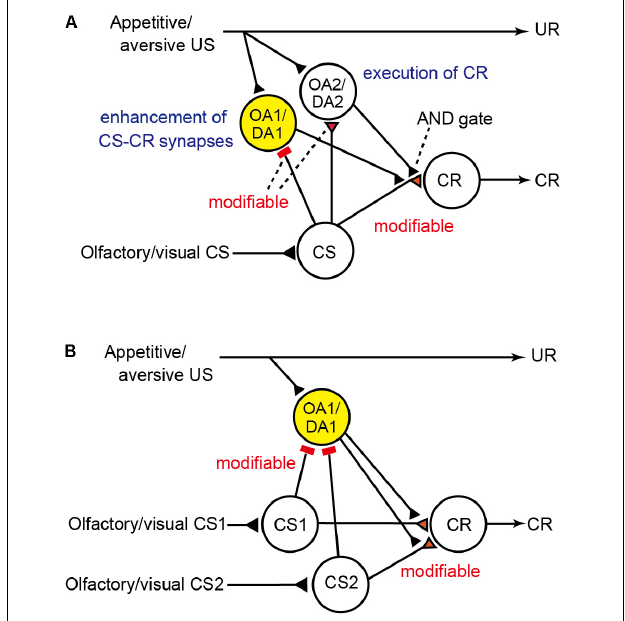
FIGURE 1 | Neural models of Pavlovian conditioning in crickets proposed by Terao et al. (2015) and Terao and Mizunami (2017). (A) Description of the model that has been revised from the model by Mizunami et al. (2009) to match the prediction error theory. The model assumes two classes of OA and DA neurons. One is “OA1/DA1” neurons (colored in yellow) that govern enhancement of “CS-CR” synapses (but not execution of a CR). The other is “OA2/DA2” neurons that govern execution of a CR or memory retrieval (but not enhancement of “CS-CR” synapses). The model also assumes that (1) “CS” neurons [which may represent intrinsic neurons (Kenyon cells) of the mushroom body] that convey signals for CS make silent or weak synaptic connections with dendrites of “CR” neurons [which may represent efferent (output) neurons of the lobes (output regions) of the mushroom body], activation of which leads to a CR, but these synaptic connections are silent or very weak before conditioning, (2) “OA1/DA1” neurons receive excitatory synapses that represent appetitive/aversive US signals and silent or very weak inhibitory synapses from “CS” neurons before training, which are strengthened by CS-US pairing, (3) during training, “OA1/DA1” neurons receive excitatory synaptic input that represents actual US and inhibitory input from “CS” neurons that represents US prediction by CS, and thus their activities represent US prediction error signals, (4) “OA2/DA2” neurons receive excitatory synapses that represent US signals and silent or very weak excitatory synapses from “CS” neurons before training, which are strengthened by CS-US pairing, and (5) “OA2/DA2” neurons make synaptic connections with axon terminals of “CS” neurons, and coincident activation of “CS” neurons and “OA2/DA2” neurons is needed for activation of “CR” neurons (AND gate) and for production of a conditioned response. Presentation of a CS after CS-US pairing activates “CS” neurons and then “OA2/DA2” neurons and thus activates “CR” neurons to lead to a CR. Synapses for which the efficacy can be changed by conditioning are colored in red and marked as “modifiable.” Excitatory synapses are marked as triangles, and inhibitory synapses are marked as bars. UR: unconditioned response. (B) Accounts for blocking by the model. “OA2/DA2” neurons in the model in (A) are not shown in (B) for simplicity. The models are modified from Terao et al. (2015) and Terao and Mizunami (2017) with